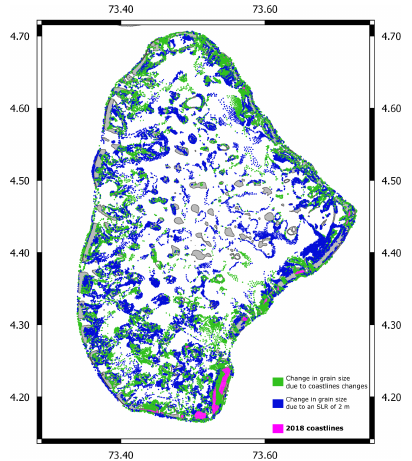
Figure 10. Comparison of changes to grain size class with differ- ent simulation scenarios, overlaid on boundaries of lagoons from Spalding et al. (2001) shown in grey. Even though there is generally more grain size class change across the atoll associated with SLR of 2m, considerable change is predicted with coastline modifications occurring over a far shorter